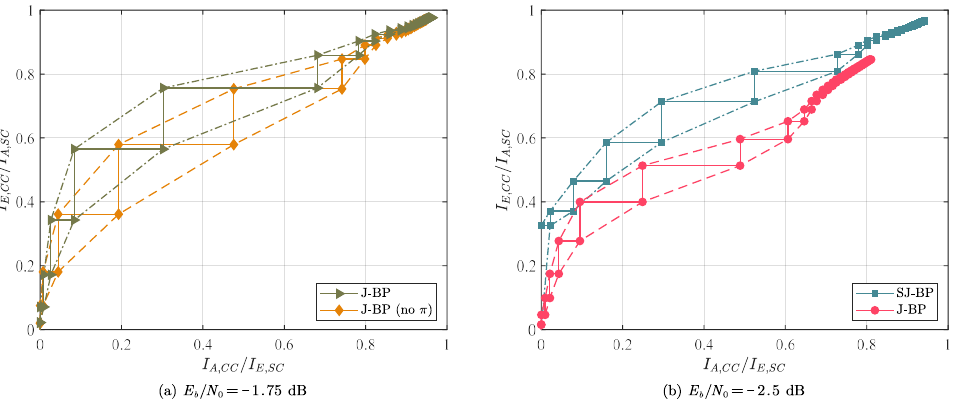
Figure 4. Two B-EXIT charts with I = 28 iterations: ( a ) impact of the optimal mapping for the D-PC scheme with E b / N 0 = − 1.75 dB and ( b ) performance comparison between D-PC and SD-PC with E b / N 0 = − 2.5